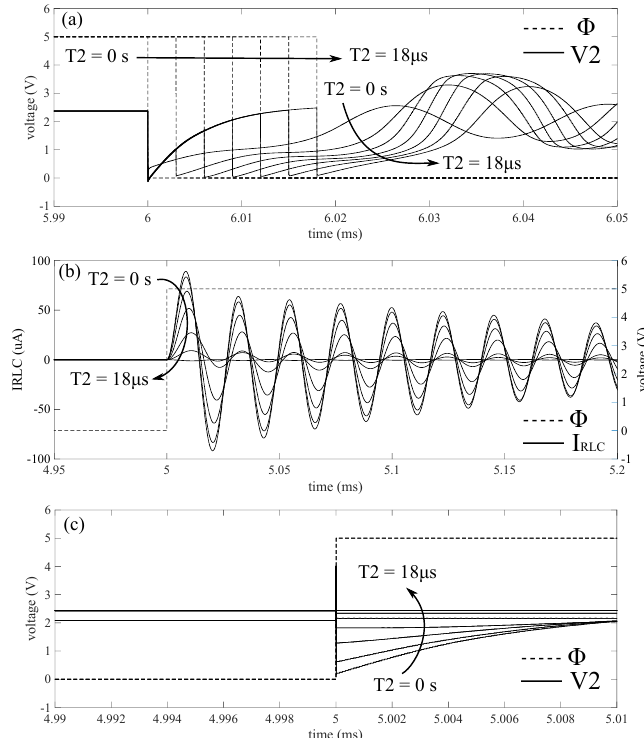
Figure 19. Simulation results of the transition read-out mode to actuation mode. ( a ) V 2 , Φ around the transition from actuation to read-out mode; ( b ) I RLC at the beginning of the actuation mode; ( c ) V 2 , Φ around the transition from read-out to actuation